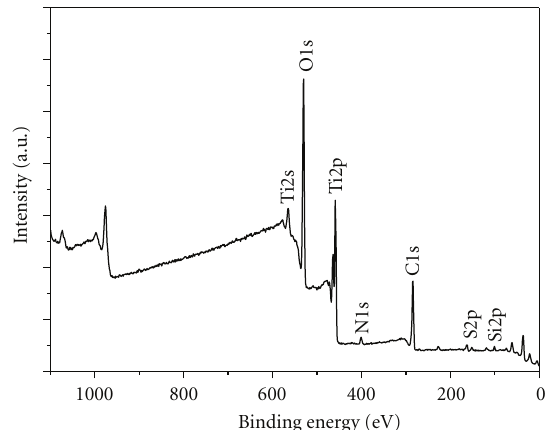
Figure 8: XPS survey spectrum for the surface of APTMPP-MPS- TiO 2 .